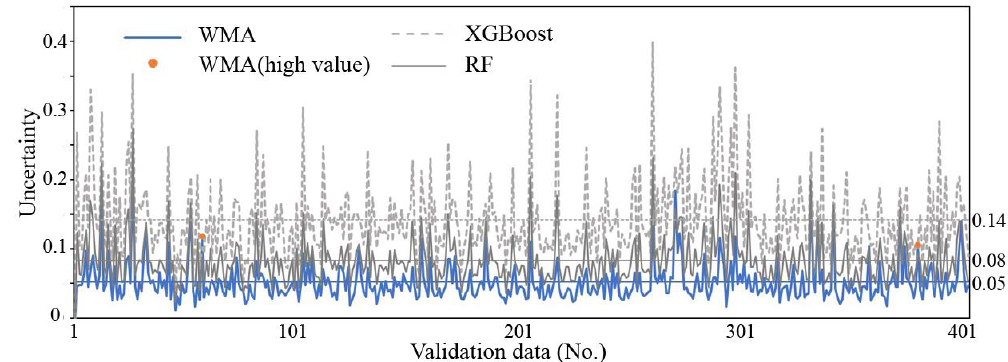
Figure 5. Plot of the uncertainty values of 402 validation data points.